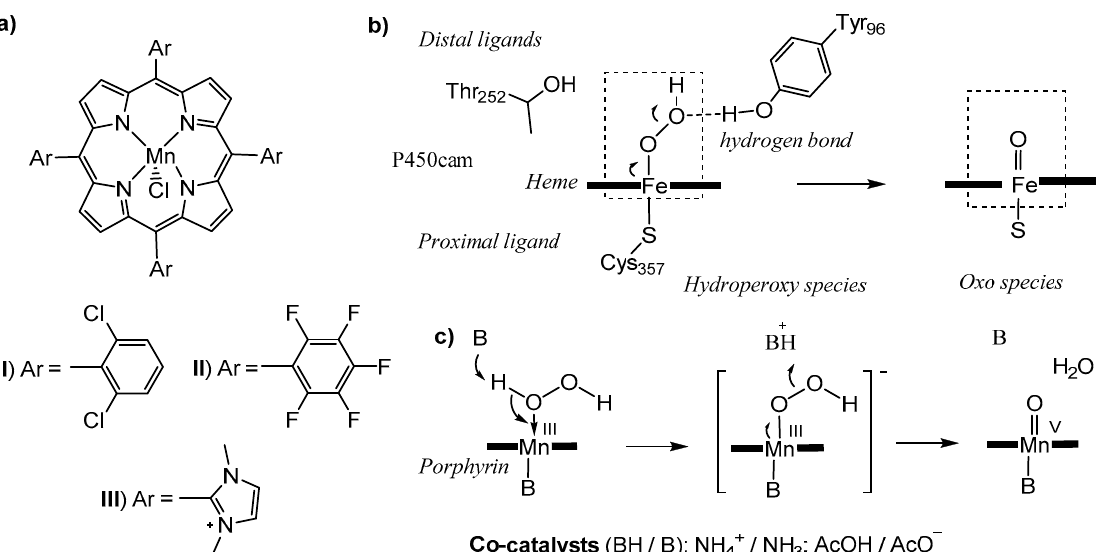
Figure 2. Biomimetic systems: ( a ) structures of the Mn(III) porphyrins used as catalysts; ( b ) adapted representation of P450cam active site [10]; ( c ) mechanism proposed for the biomimetic generation of oxo-species, where the co-catalysts mimic the action of proton-donating amino acids from the P450 active site.